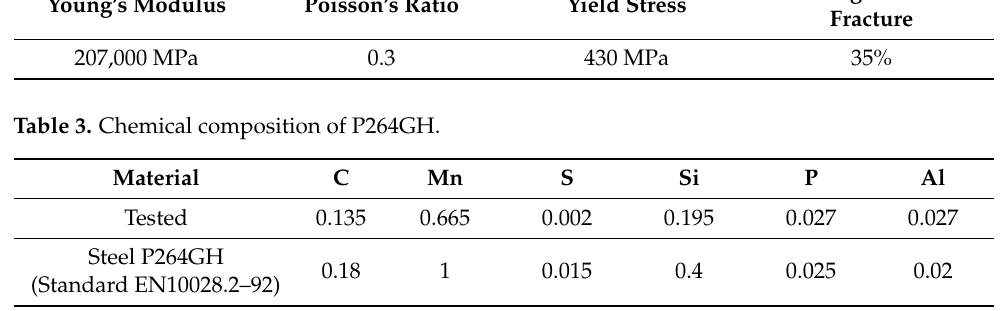
Table 2. Mechanical characteristics of P264GH.